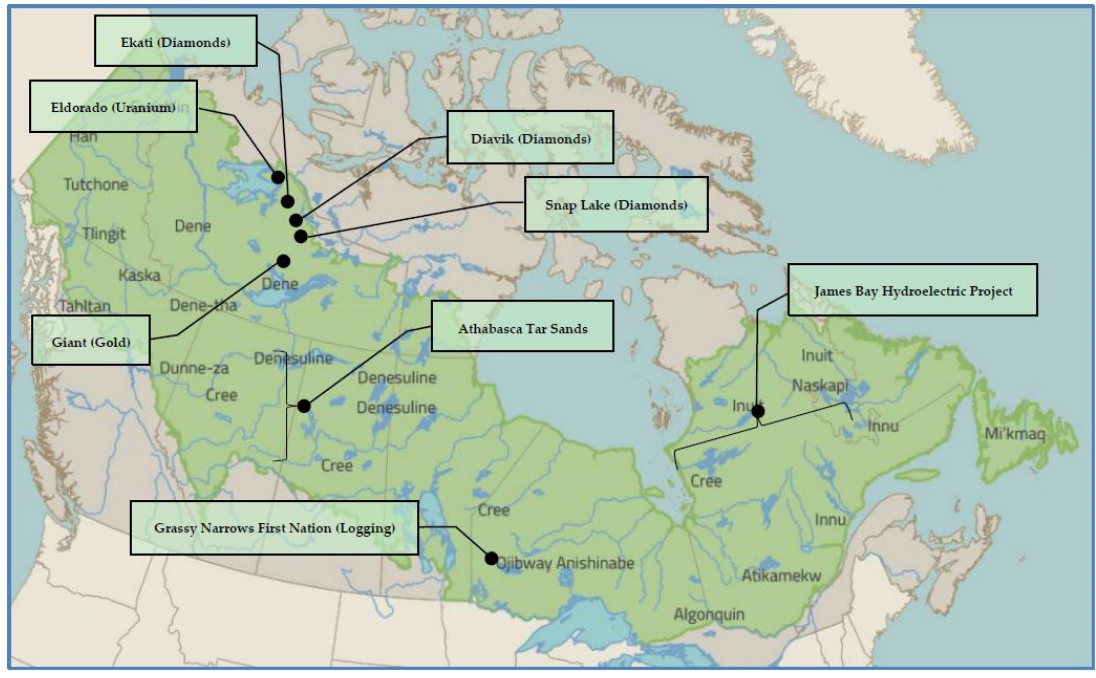
Figure 1. The approximate extent of Canada’s boreal forest, the main subarctic Indigenous groups, and the major extraction sites noted in the text [9].